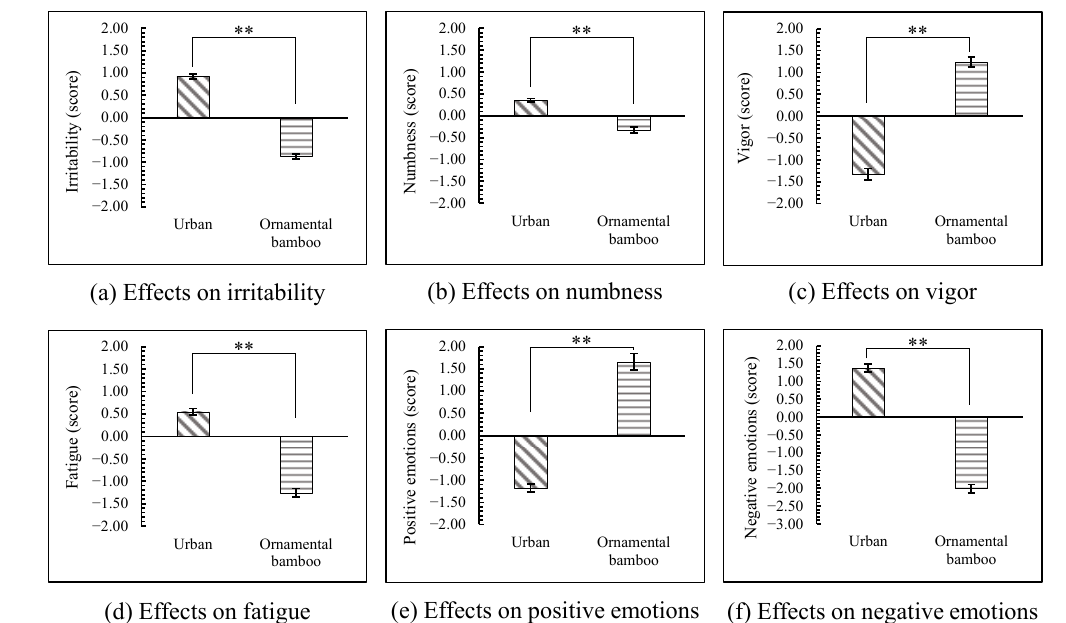
Figure 4. Comparison of psychological indicators after the participants viewed the stimulus images between urban and ornamental bamboo groups. The zero point represents the value measured after participants having a rest. n = 300; mean ± SE; ** p < 0.01.